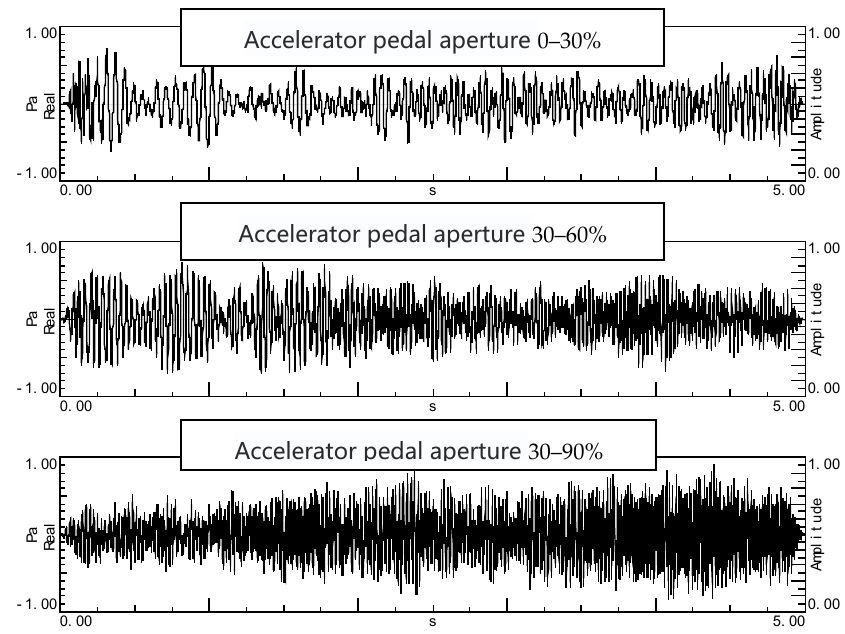
Figure 25. Synthesized sound signals under different accelerator pedal aperture changes.